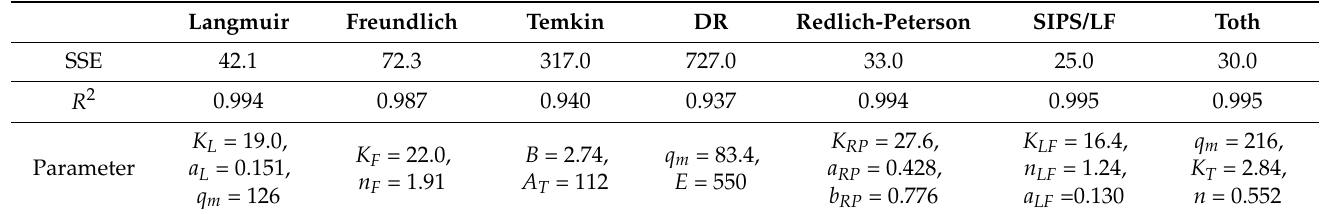
Table 3. Isotherm Parameters and SSE of IBU adsorption on date stone activated carbon.